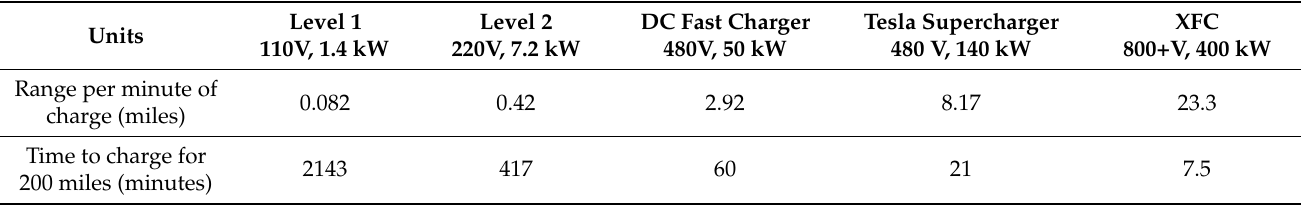
Table 1. Comparison of Extremely Fast Charging (XFC) of EVs with Currently Available Charging Infrastructures. Repro- duced from [55], U.S. Department of Energy: